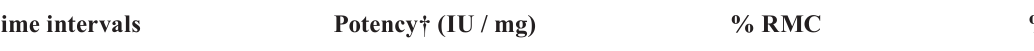
Time intervals Potency† (IU / mg) % RMC % Free IFN Real-time storage: between +2 °C and +8 °C Initial 0.51 × 10 8 0.16 % 2.38 %